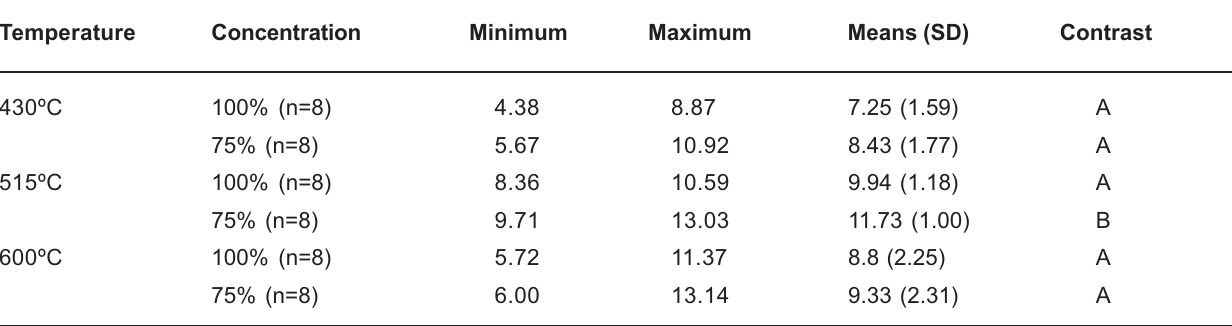
Different letters indicate statistically significant difference at 5%.